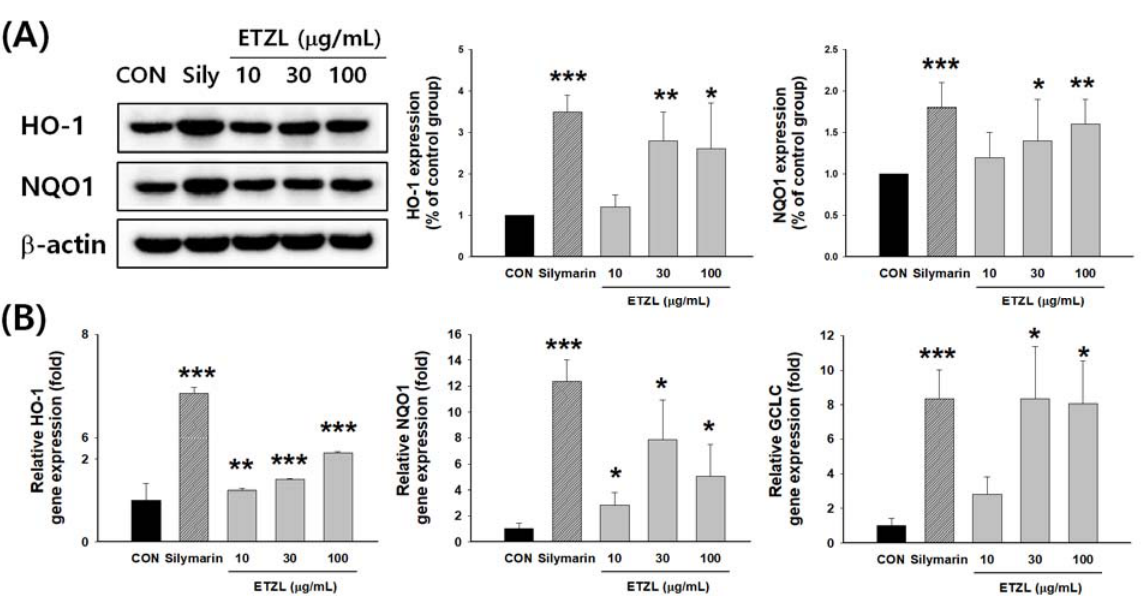
Figure 7. Effects of ETZL on downstream target gene of Nrf2 in hepG2 cells: ( A ) Expression of HO-1 and NQO1 protein. ( B ) Expression of HO-1, NQO1, and GCLC mRNA in HepG2 cells. Cells were incubated for 12 h with the indicated concentrations of ETZL. Values are expressed as mean ± SD ( n = 3). Significant differences compared with the control (CON) are indicated by * p < 0.05, ** p < 0.01 and *** p < 0.001.